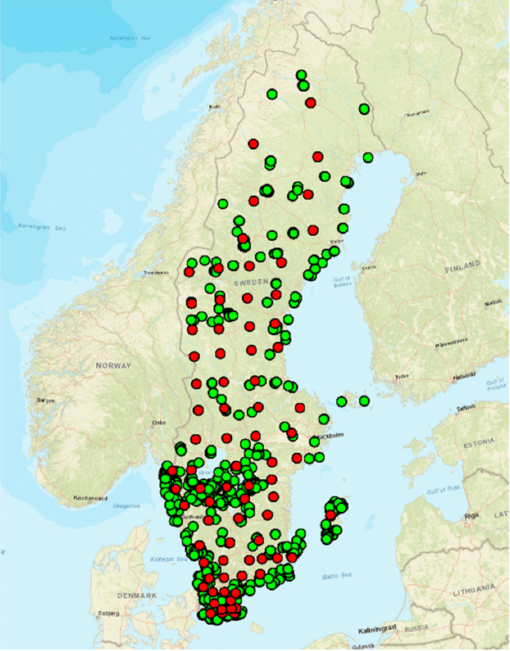
Figure 1. A map of the locations of wind turbines included in this study (green) and index sites used for normal wind-year normalization (red); see Section